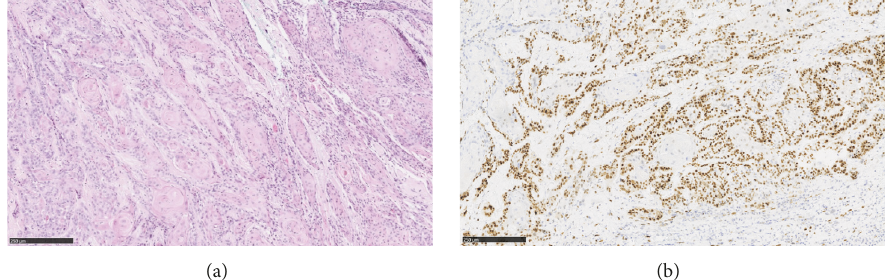
Figure 3: Microscopic and immunohistochemical aspects of 1st excision . Tumor consisted of nests of invasive squamous cell carcinoma, with focal keratinization (a). p53 appeared continuous and limited to the periphery of invasive nests, with strong intensity (b).